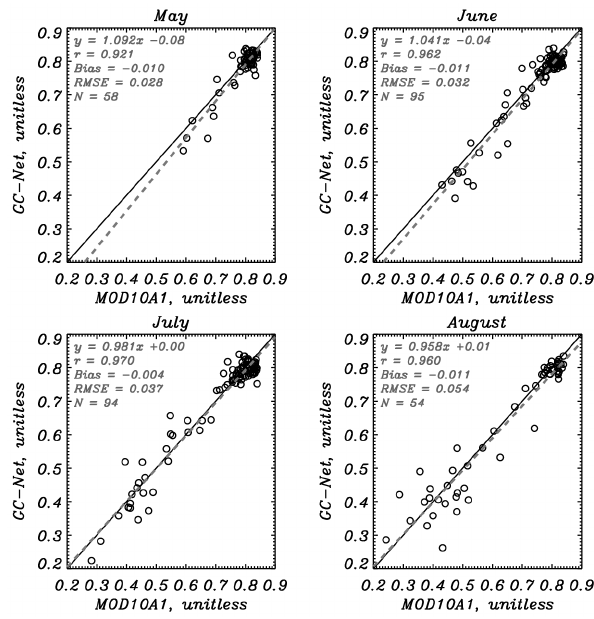
Fig. 1. Comparison of the monthly averaged MODIS MOD10A1 values less than 0.84 within 10 km of 17 GC-Net automatic weather stations. The June–August average RMS error is